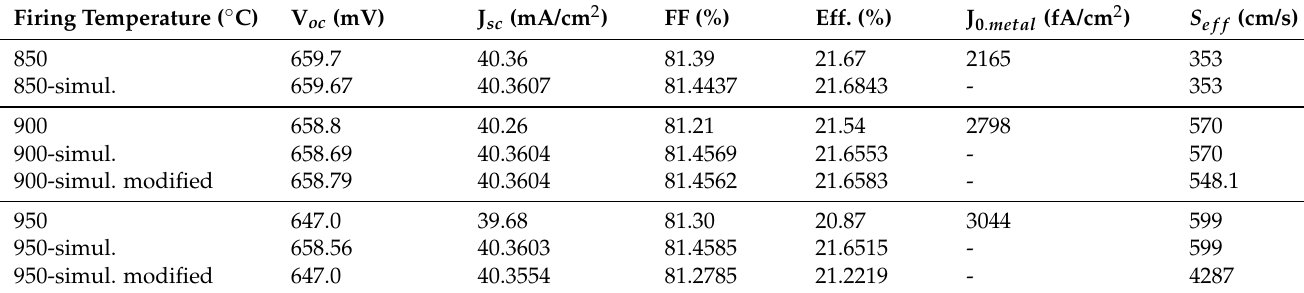
Table 1. Results of the PERC solar cell LIV measurements for different firing temperatures, and a comparison with simulation.